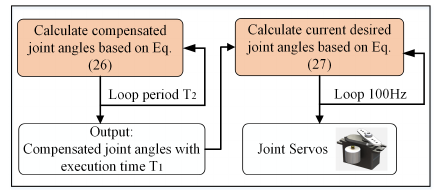
Figure 4. Flow chart of the proposed trajectory following